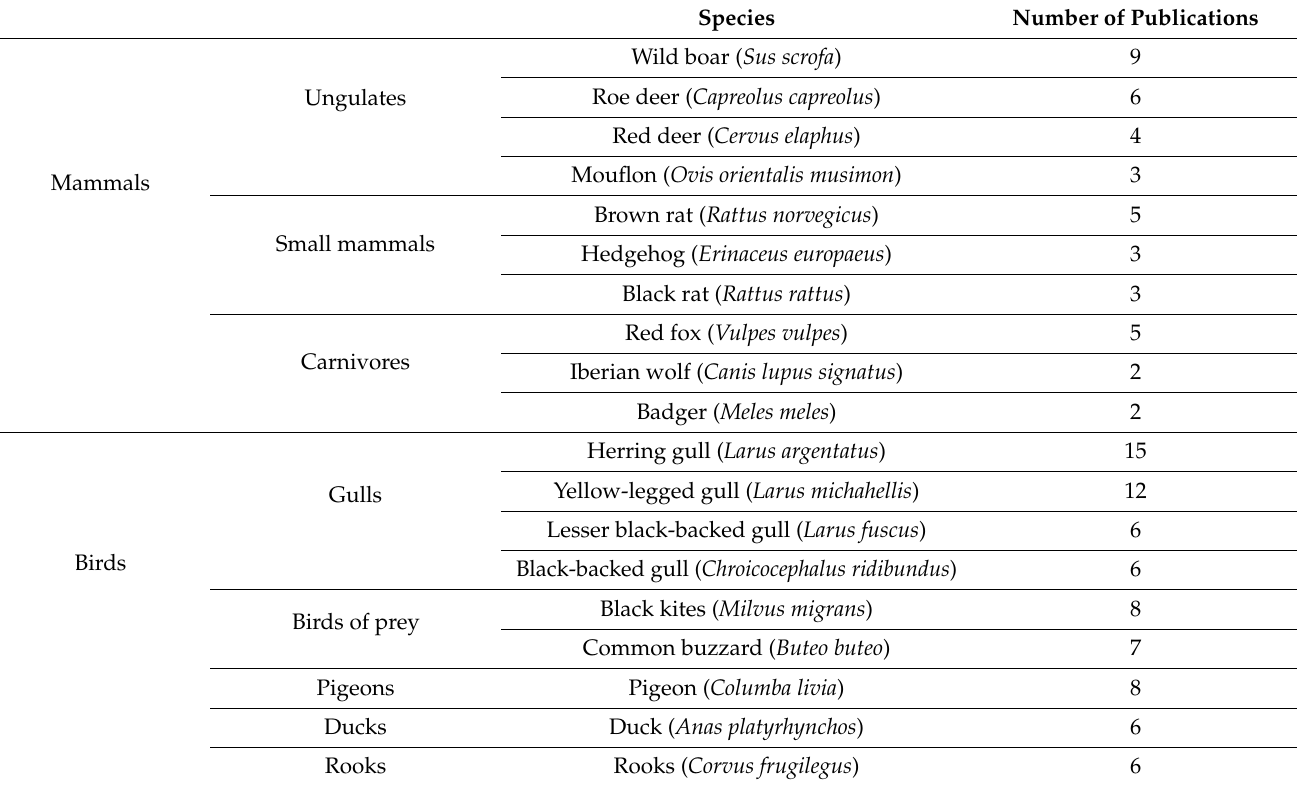
Table 2. Top 10 of wildlife host species (mammals and birds) with reported cephalosporinases